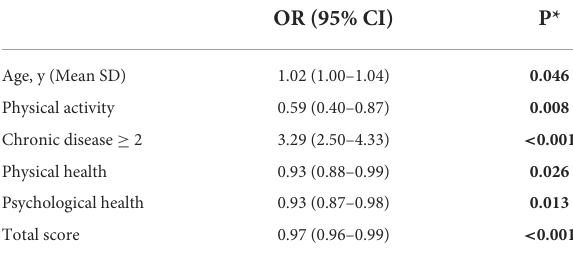
TABLE 5 Multivariable models showing factors associated with GDS-15 ≥ 5 among empty-nest